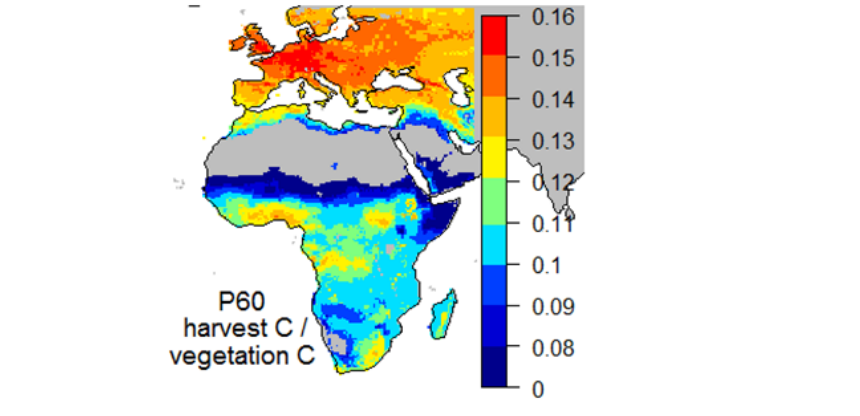
Figure A3. Annual ratio of C removed by harvest and C stored in vegetation, averaged over the whole agricultural period and for P60. As only aboveground biomass is harvested, lower values indicate increased C allocation to roots compared to leaves due to limited water supply.